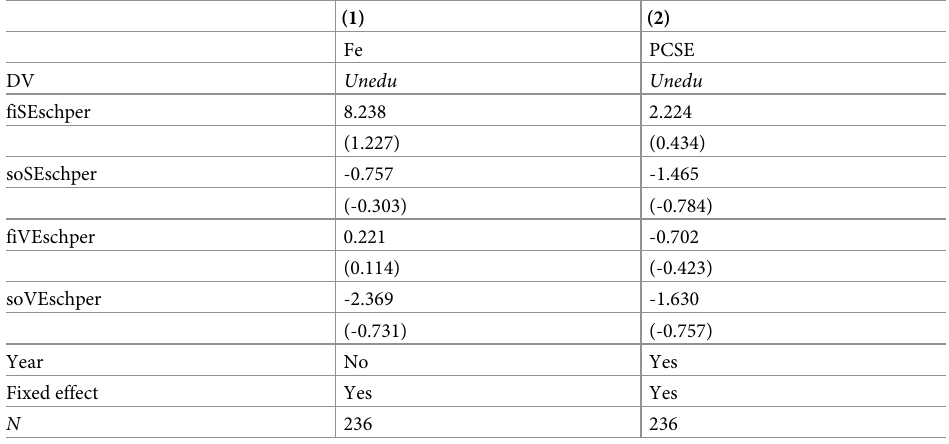
Table 14. The results of scholarship expense on RSE correction with